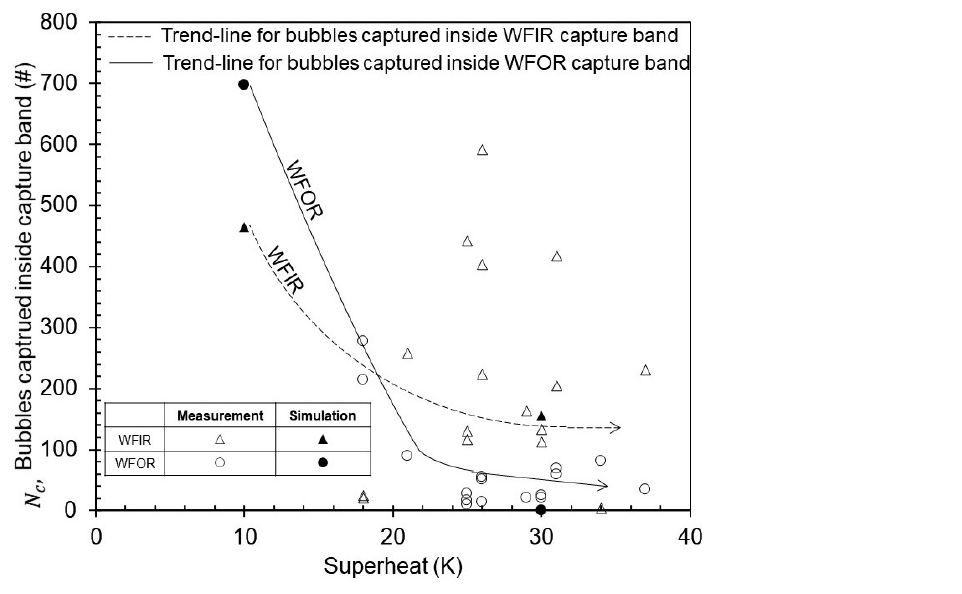
Figure 17. Model validation—number of bubbles captured in the capture band comparing simulation and UT